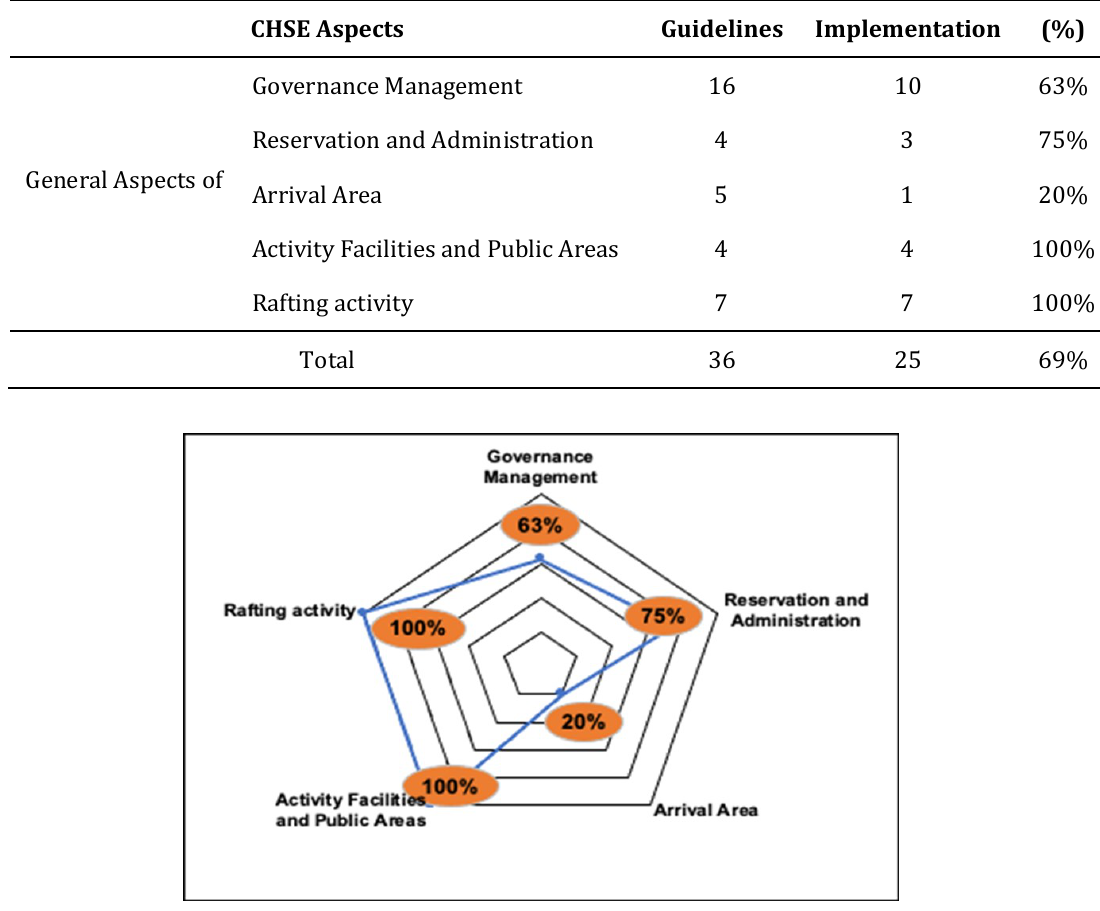
Fig. 1. Percentage of implementation of CHSE special guidelines on Payung Rafting tourism